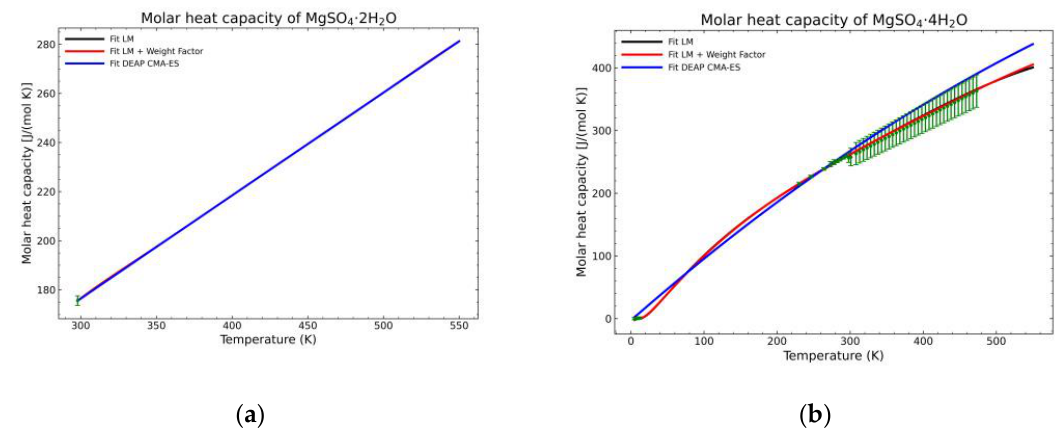
Figure 13. Comparison of the different fit results, showing the literature data in green (mean of the values) with the 95% confidence interval boundaries of: ( a ) MgSO 4 ·2H 2 O; ( b ) MgSO 4 ·4H 2 O.